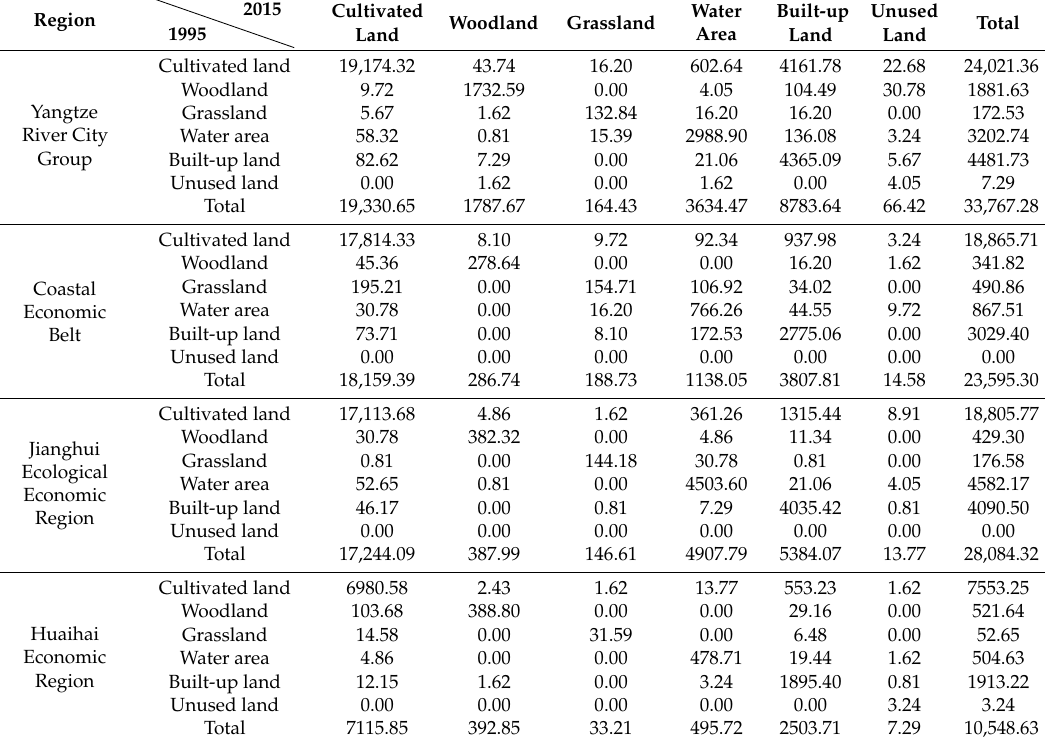
Table 5. The land transformation matrix for the Jiangsu Province between 1995 and 2015 (km 2 ).